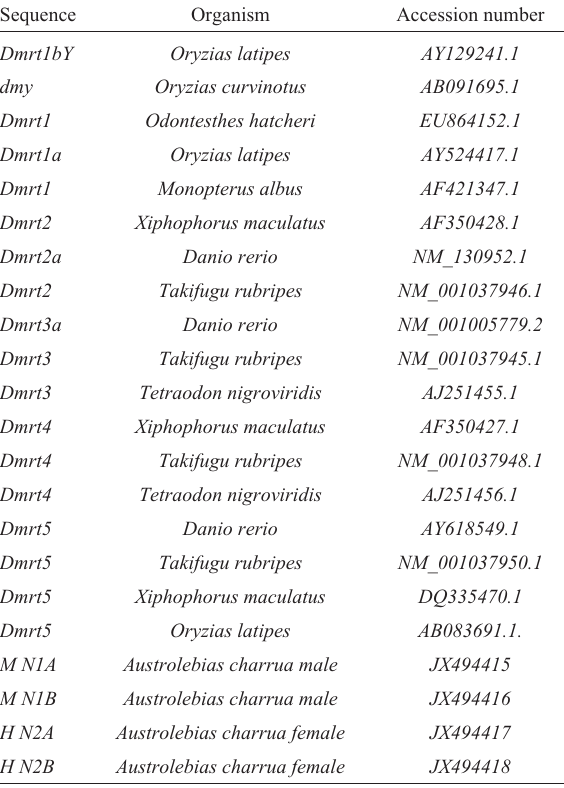
Table 2 - Dmrt gene family obtained from GenBank and fragments iso- lated from the Austrolebias charrua genome.